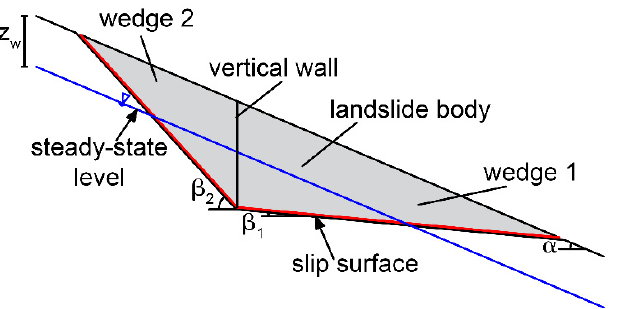
Figure 1. Schematization of the unstable soil mass with a two-wedges